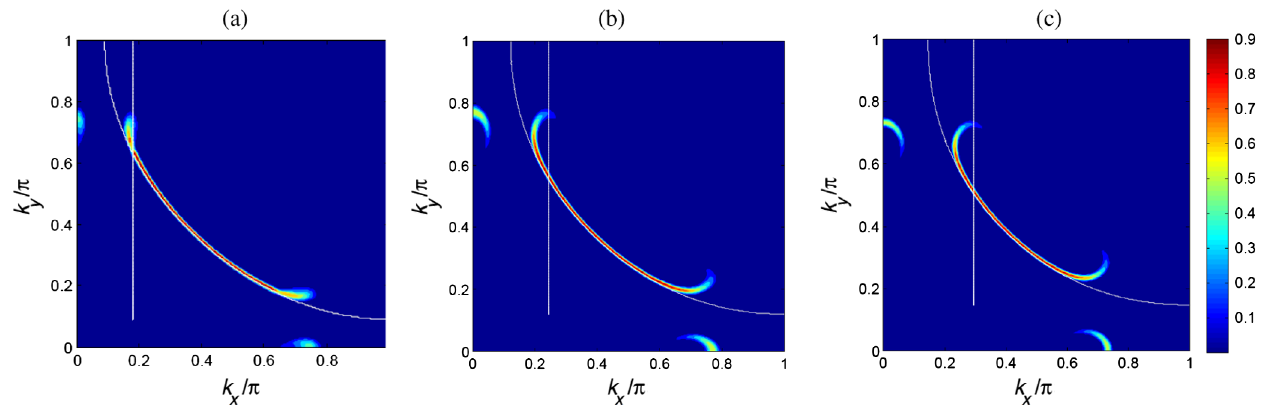
FIG. 13. Spectral weight at the Fermi level. Same as Fig. 4 except that (a) Δ 0 ¼ 100 meV, p ¼ 0 . 207 , (b) p ¼ 0 . 157 and Δ 150 meV, (c) p ¼ 0 . 112 and Δ 0 ¼